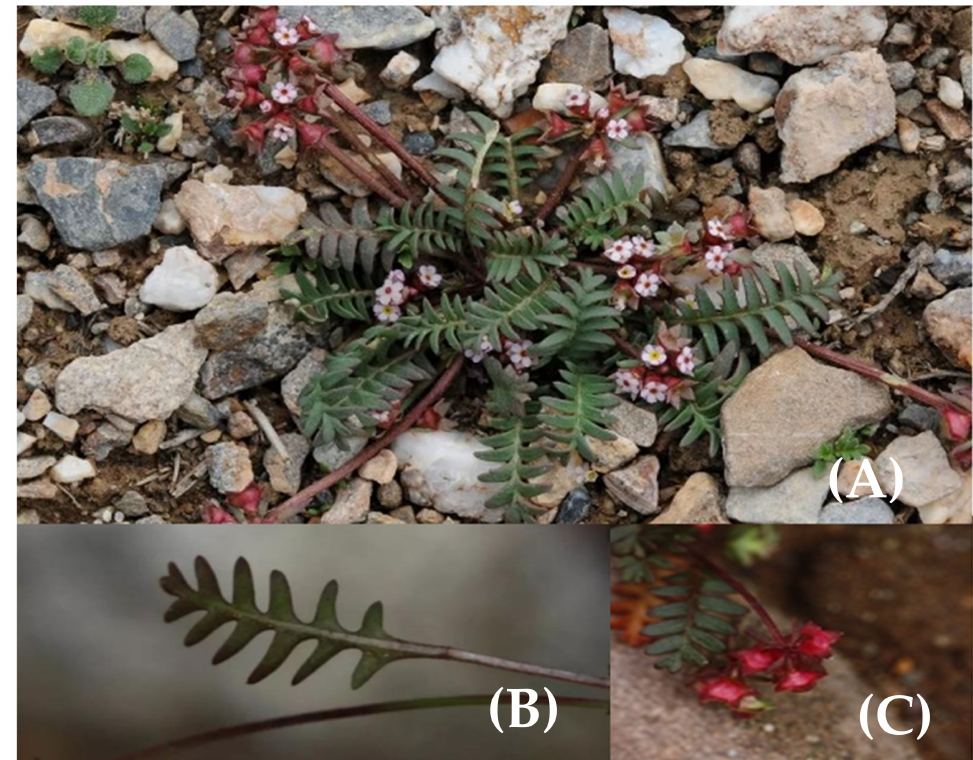
Figure 1. Pomatosace filicula : ( A ) in natural habitat; ( B ) leaf of Pomatosace filicula ; ( C ) flowers of Pomatosace filicula . (Figure taken from ppbc.iplant.cn website (accessed on 6 October 2021), pho- tographed by Yuhu Wu and Xinxin